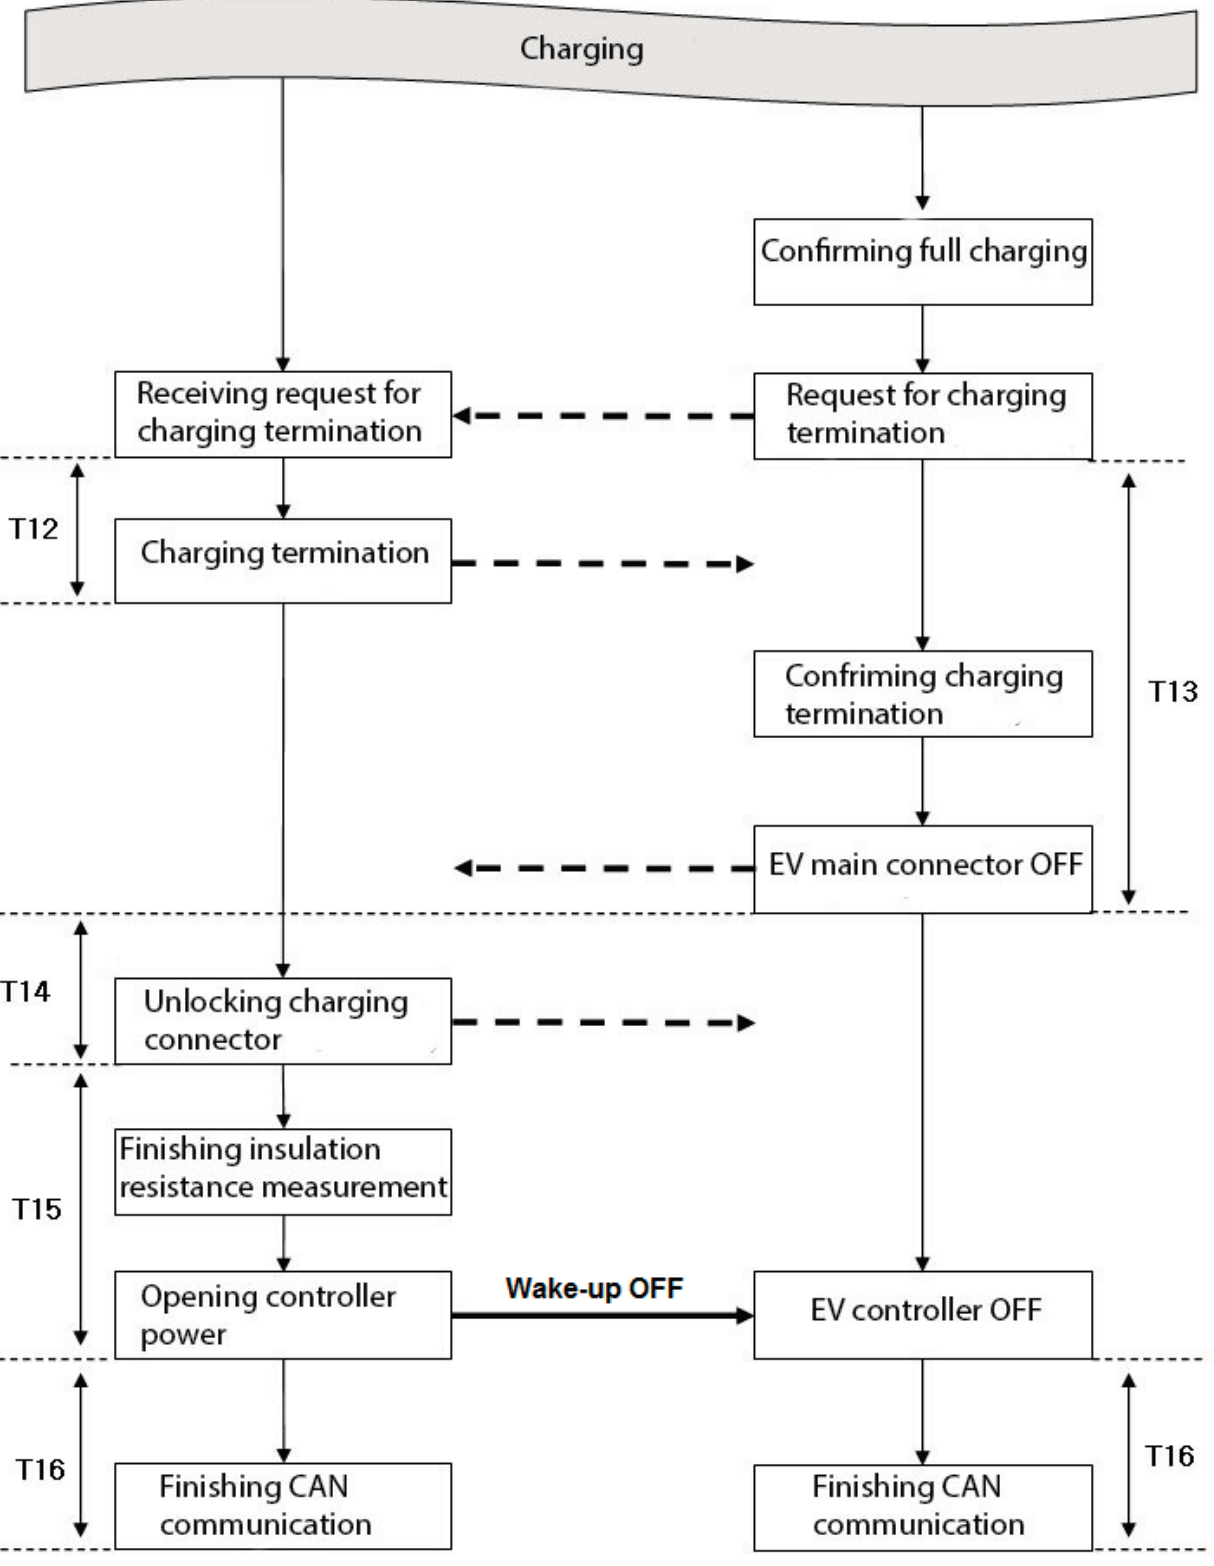
Figure 2. Flow diagram of a normal charging